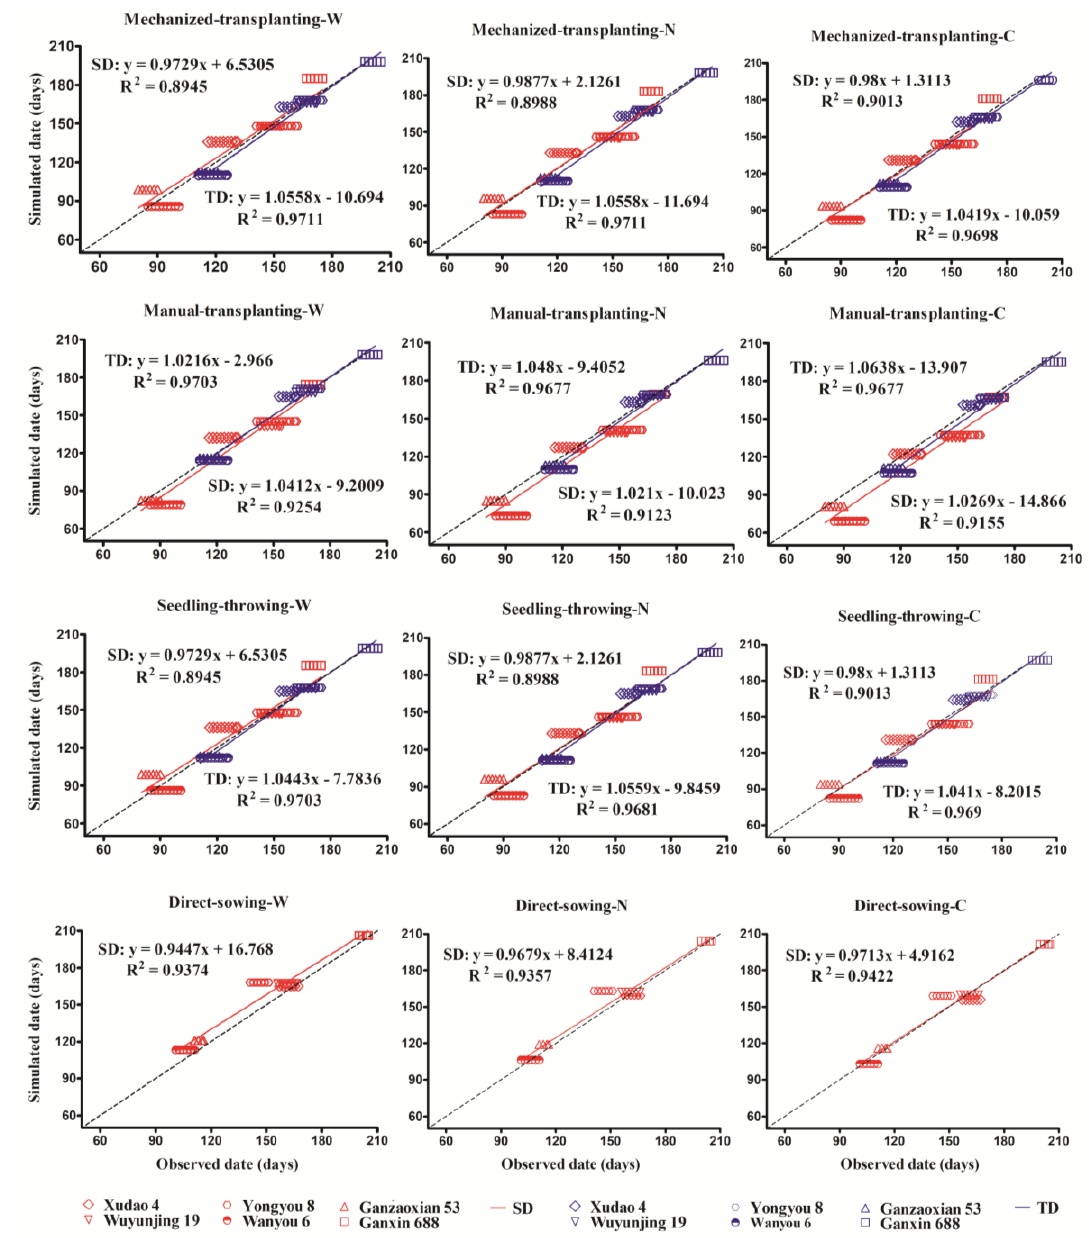
Figure 2. Comparison between observed and simulated sowing dates in red and transplanting dates in blue for rice under di ff erent planting methods, climatic years and cultivars. SD, line of linear regression between observed and simulated values for sowing dates; TD, line of linear regression between observed and simulated values for transplanting dates. Short dashed lines are the 1:1 relationship lines. W, Warm year; N, Normal year; C, Cool year. For example, mechanized-transplanting-W means sowing and transplanting dates for mechanized transplanting rice in warm year.